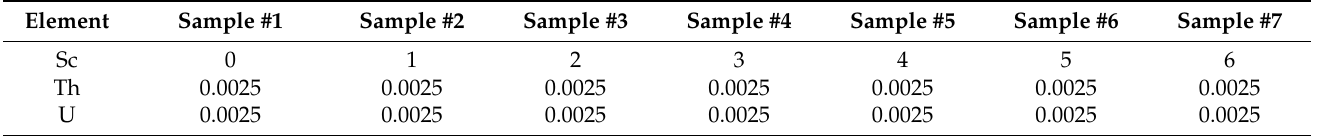
Table 6. The concentration of Th and U in seven groups of feed solution set to test the influence of scandium matrix concentration on the detection of Th and U.